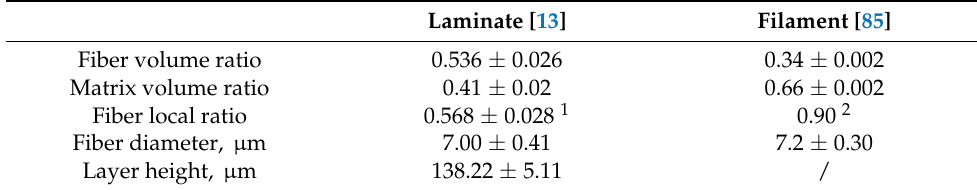
Table 2. Volume fraction comparison.